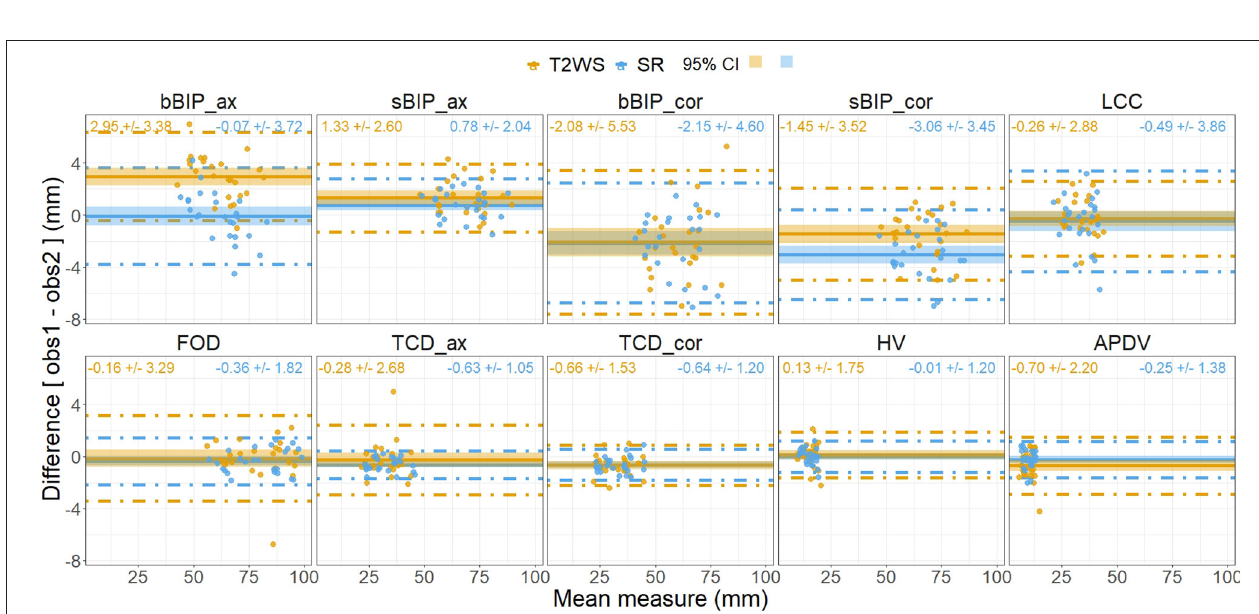
FIGURE 8 | Bland–Altman plots of measurement differences between observers (observer 1 vs. observer 2) for each dataset [intra-dataset, T2-weighted sequence (T2WS) and super-resolution (SR)] for each biometric measurement. Each point corresponds in the x-axis to the mean measure between observers and in the vertical y-axis to the difference in mm between the two observers on T2WS (orange point) and SR (blue point). Horizontal solid line = mean of all measurements for T2WS (blue) and SR (red); dashed lines = 95% limits of agreement, and shadow areas correspond to the 95% confidence interval (CI).